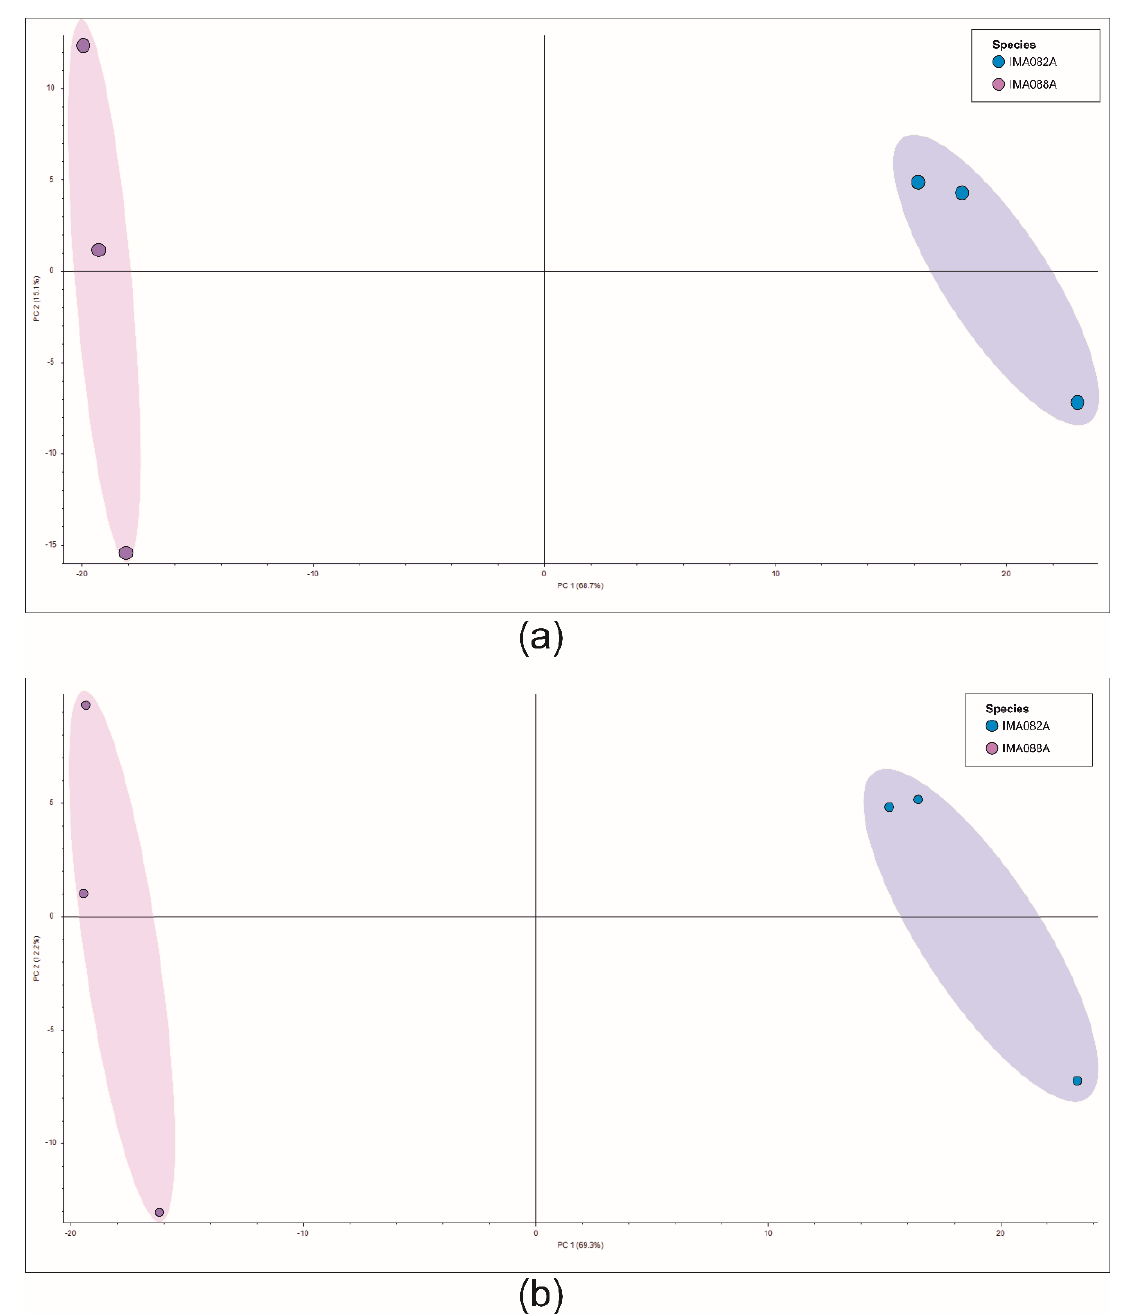
Figure 6. Principal components analysis (PCA) of metabolomic profiles of C. ineffabilis IMA082A and C. zucchellii IMA088A. The x − and y − axes represent principal components 1 and 2, respectively, while the percentages in brackets indicate how much of the overall variance in each dataset is explained by each principal component. Chemical profiles of three independent replicates were analyzed per Craspedostauros strain. ( a ) Positive ion mode; ( b ) Negative ion mode.